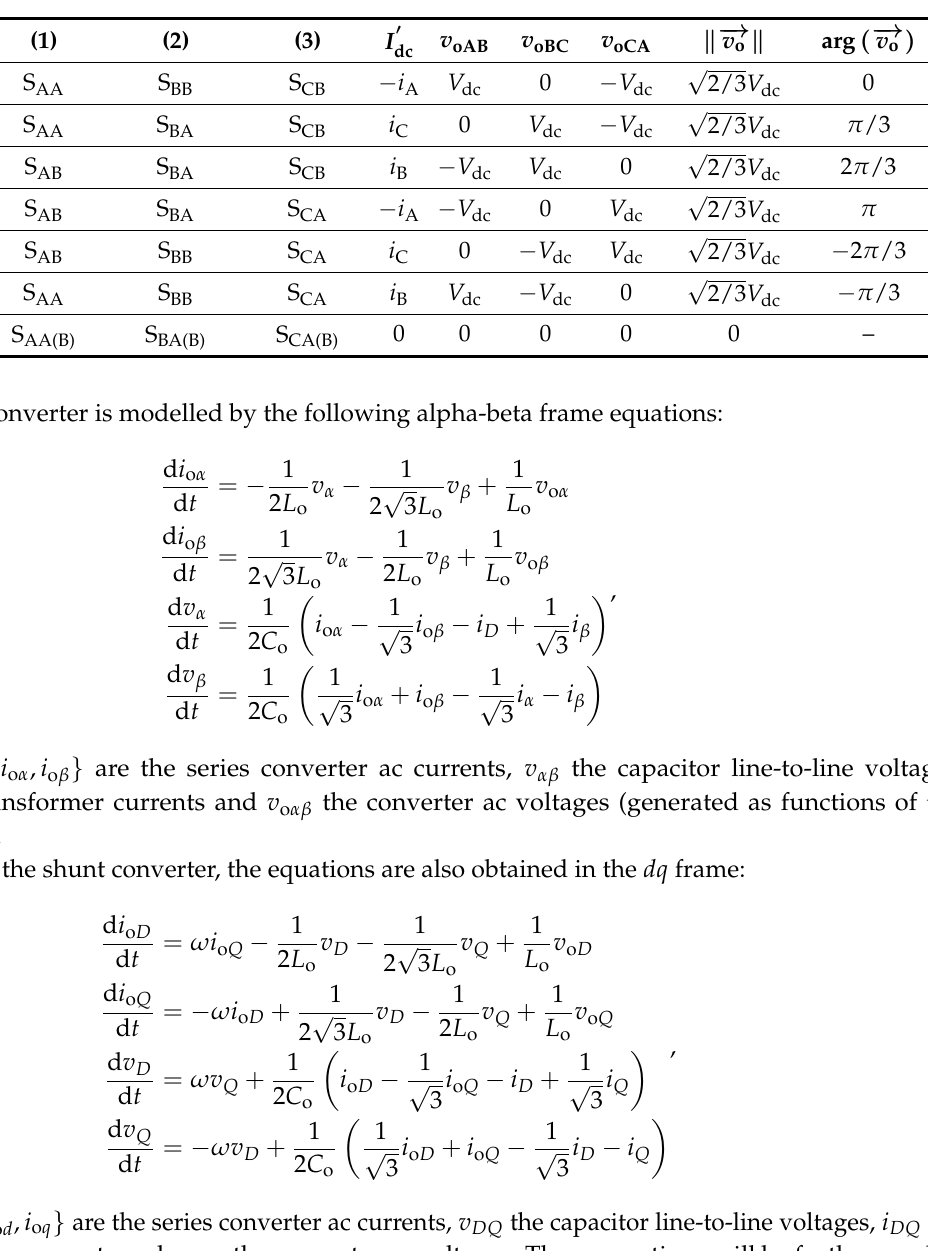
Table 2. Switching states of the series converter with the switches conducting on the first (1) , second (2) and third (3) leg, with their effect on ‘dc link’ current and ac